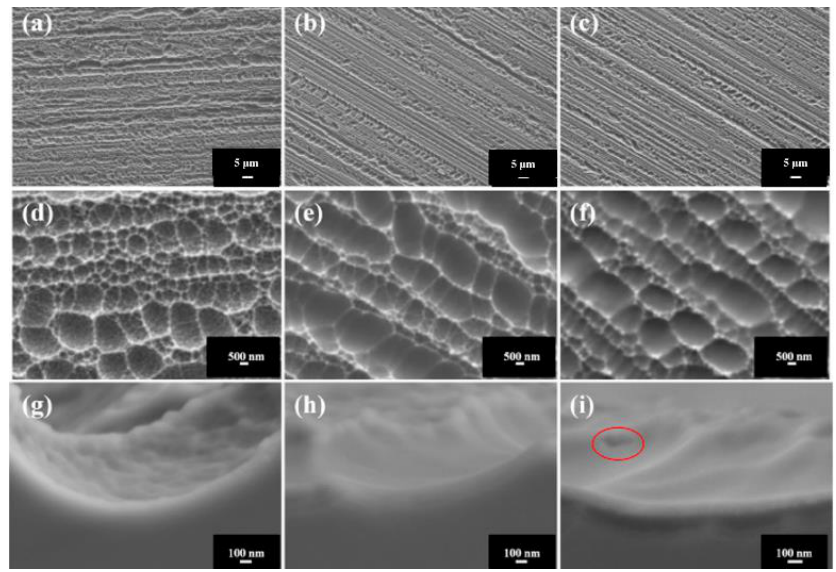
Figure 4. FESEM images of the polysilicon solar cells coated with: ( a , d , g ) SiN x , ( b , e , h ) SiO 2 /SiN x , and ( c , f , i ) TiO 2 –SiO 2 /SiO 2 /SiN x ARC. In the red circle is a crack caused by the volatilization of organic matter in the sol during annealing. The image scales of ( a,b,c ), ( d,e,f ), and ( g,h,i ) are 5 µ m, 500 nm, and 100 nm, respectively. Reprinted with permission [48]; 2020, Elsevier.